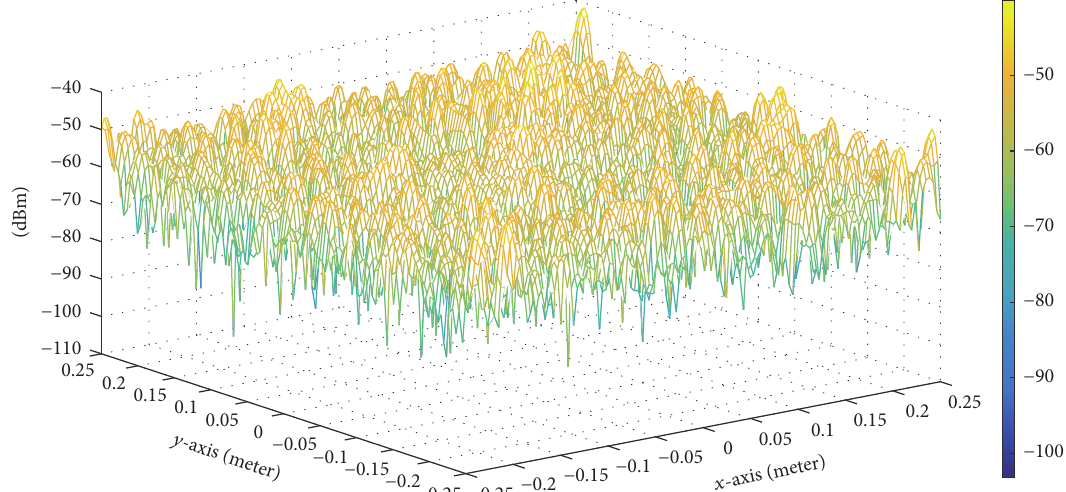
Figure 17: The power distribution of tomographic image after applying CLEAN algorithm for irregular complex target shape geometry.